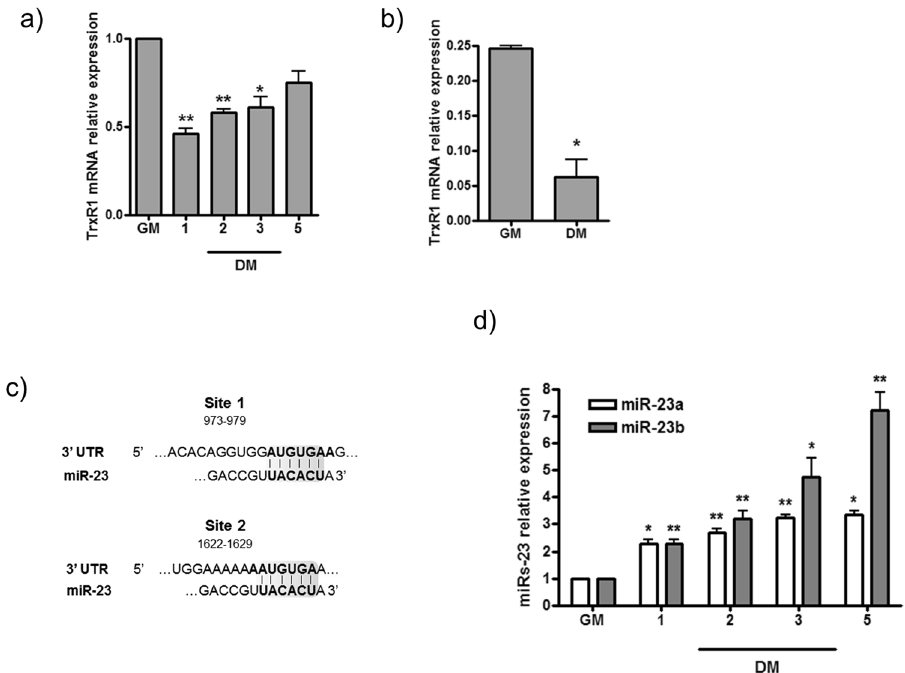
Figure 4. miR-23 is a putative regulator of TrxR1 expression during skeletal muscle differentiation. ( a ) RT- qPCR analysis showing the relative expression of TrxR1 mRNA in proliferating (GM) versus differentiating (DM) C2C12 cells collected at 1, 2, 3 and 5 days. Data were normalised to Cyclophilin A expression and represented as mean ± SEM of three independent experiments. ( b ) Relative expression of TrxR1 mRNA in proliferating (GM) versus differentiating (DM) satellite cells, measured by RT-qPCR and normalized to GAPDH expression. ( c ) Putative miR-23a and b binding sites in the 3 ′ UTR of TrxR1 mRNA. ( d ) RT-qPCR analysis displaying miR-23a andmiR-23b expression (normalized to U6 snoRNA) in C2C12 proliferating (GM) versus differentiating (DM) cells. Data are exposed as mean ± SEM of three experiments. The normalised GM values of each miRNA were set =